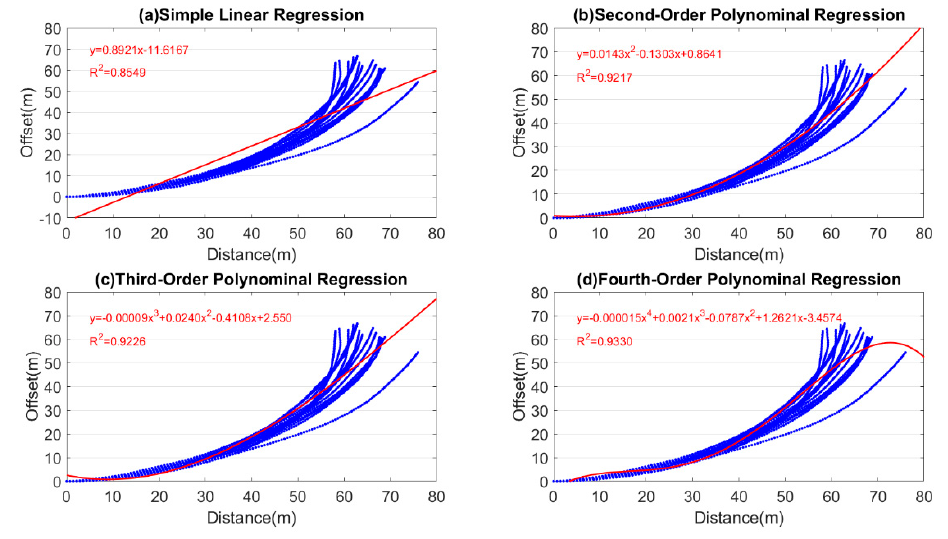
Figure 7. Regression analysis of the linear experimental field.